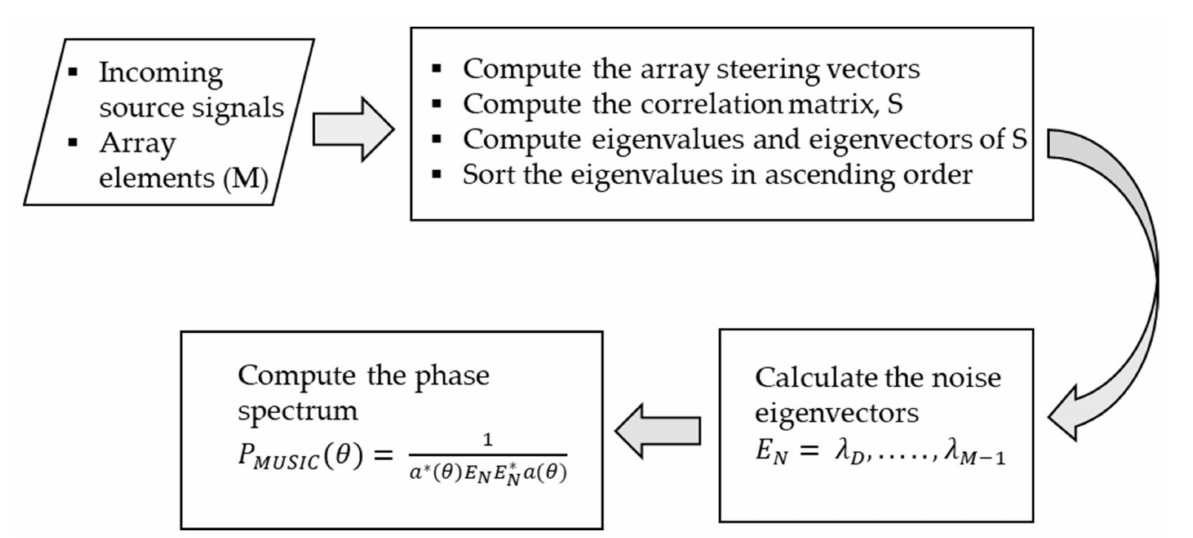
Figure 2. Flowchart for the MUSIC algorithm.